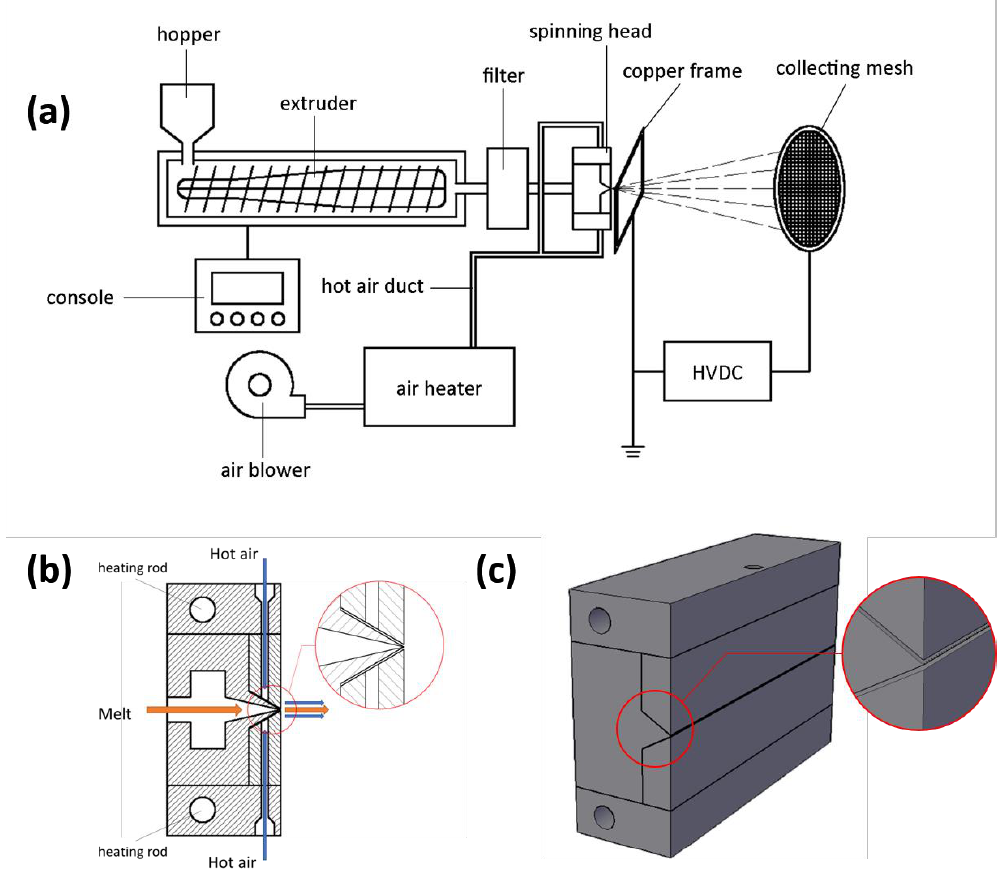
Figure 1. The schematic illustration of the electrostatic-assisted melt-blown system setup ( a ) and the details around the spinning head ( b , c